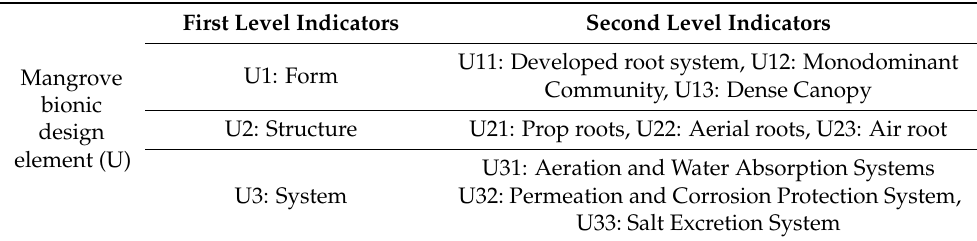
Table 1. The evaluation index of mangrove bionic